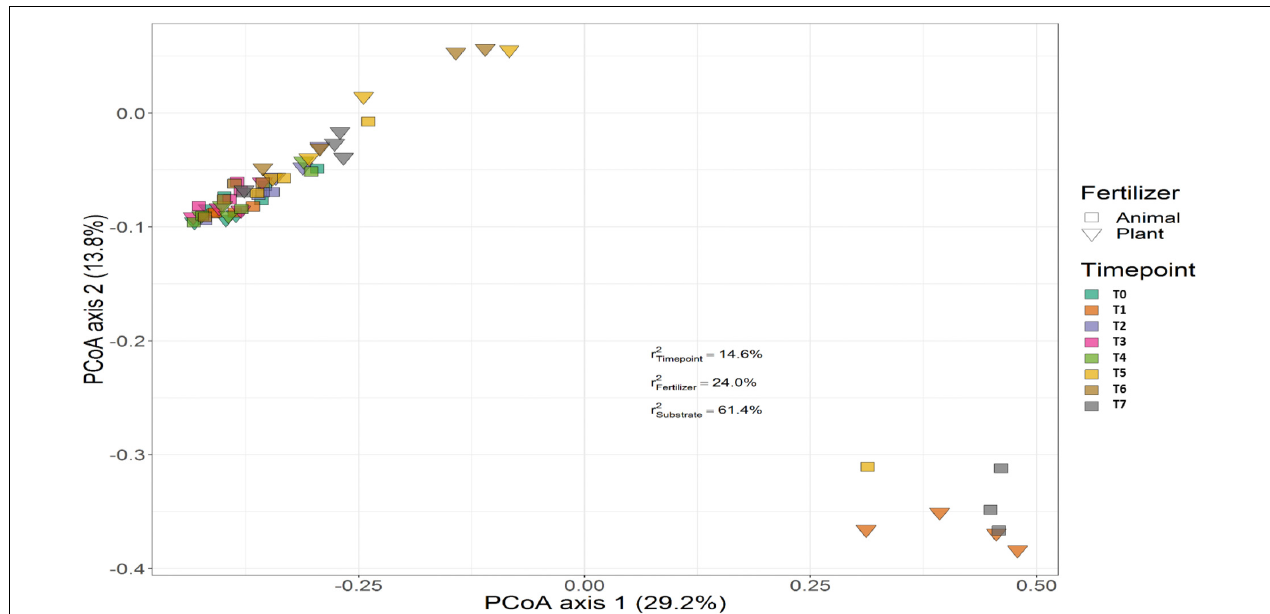
FIGURE 7 | Beta diversity of bacterial communities in soil harboring tomato plants and supplemented with different fertilizers. Squares indicate communities from soil fertilized with animal-origin fertilizer and inverted triangles show communities supplemented with plant-derived fertilizer. Samples of soil were followed over time to observe the bacterial community development. A color code on the right indicates the community sampled at different time points (time point 0-time point 8). “Substrate” indicates whether culture system contributed to the variance among bacterial communities. PERMANOVA results indicate that substrate (soil or growing medium) is the factor explaining the highest percentage of the variance among communities in the rhizosphere in both culture